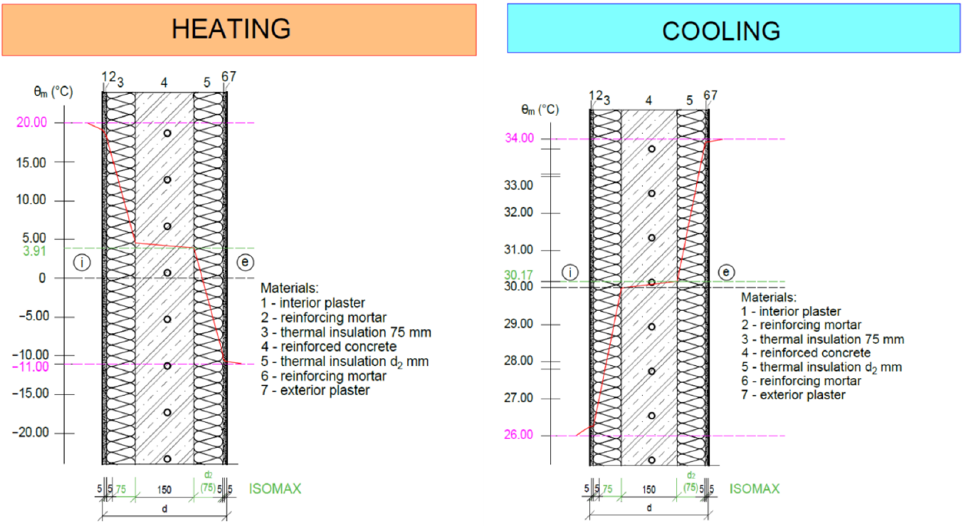
Figure 5. Temperatures in individual layers of the ISOMAX panel, i — interior, e — exterior.